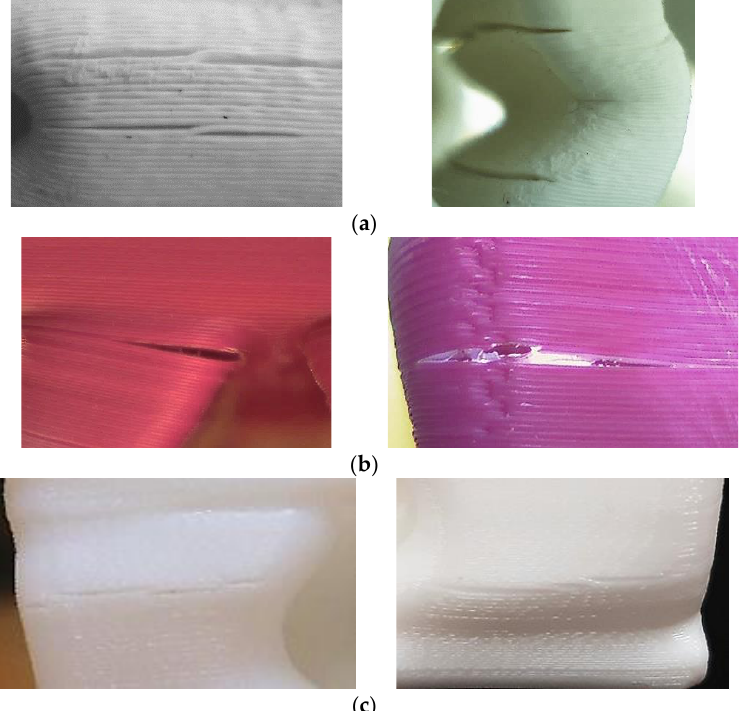
Figure 11. Images of damage between the fused plastic filament of FDM-printed heels: ( a ) heels from PLA; ( b ) heels from ABS; ( c ) heels from PA (NYLON).